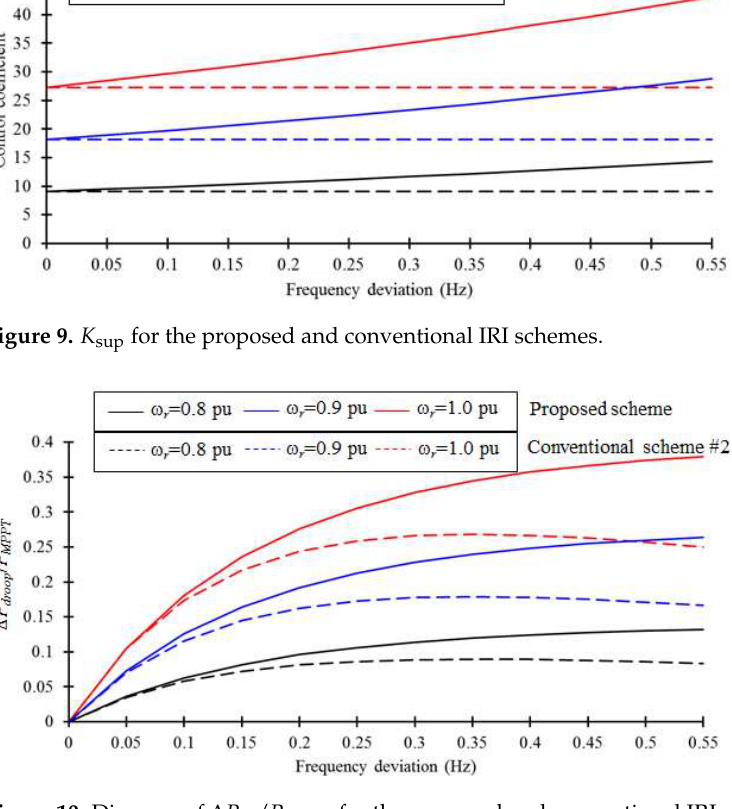
Figure 10. Diagram of Δ P dr / P MPPT for the proposed and conventional IRI schemes.